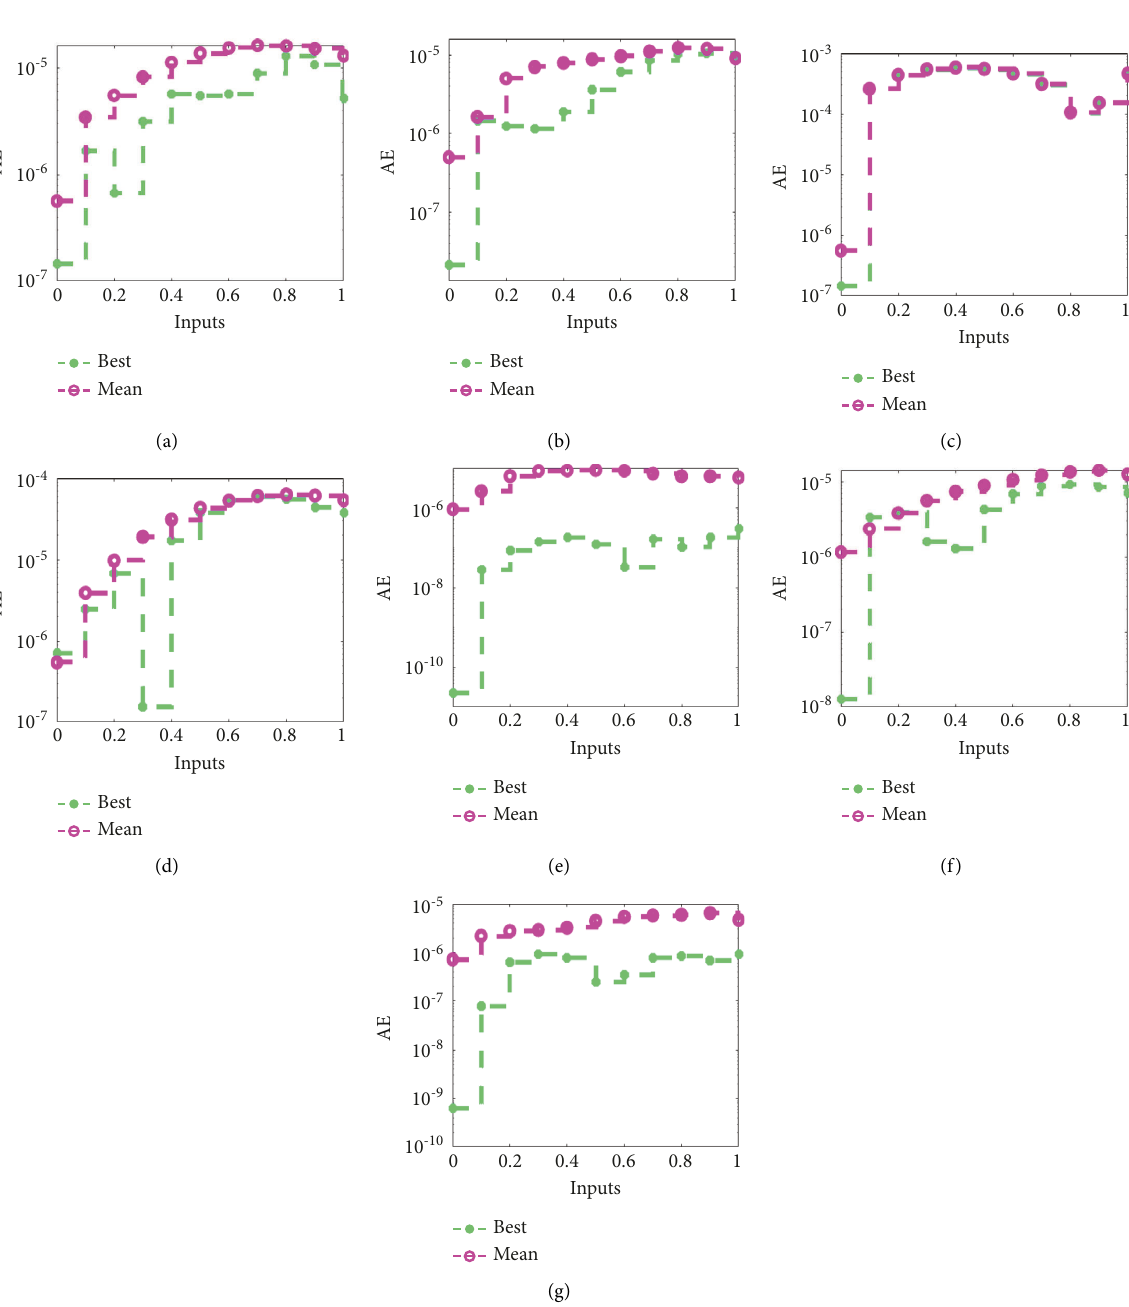
Figure 4: AE using the mean and best results for the nonlinear system. (a) AE performances for 􏽢 S ( y ) . (b) AE performances for 􏽢 E ( y ) . (c) AE performances for 􏽢 I ( y ) . (d) AE performances for 􏽢 R ( y ) . (e) AE performances for 􏽢 N ( y ) . (f) AE performances for 􏽢 D ( y ) . (g) AE performances for 􏽢 C ( y )